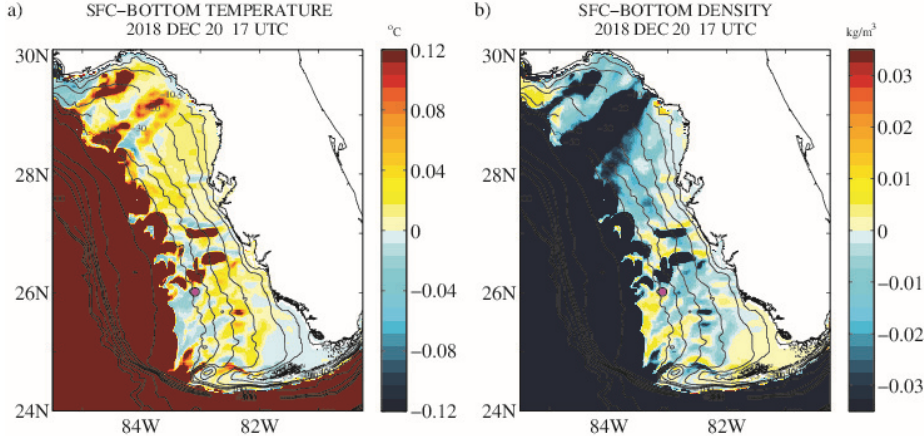
Figure 7. ( A ) COAMPS temperature results (surface–bottom) for 20 December 1700 UTC, where Figure 7. ( a ) COAMPS temperature results (surface–bottom) for 20 December 1700 UTC, where negative values (blue) indicate temperature inversions; and ( B ) the bottom density ( σ t ) minus sur- negative values (blue) indicate temperature inversions; and ( b ) the bottom density ( σ t ) minus face density. surface density.